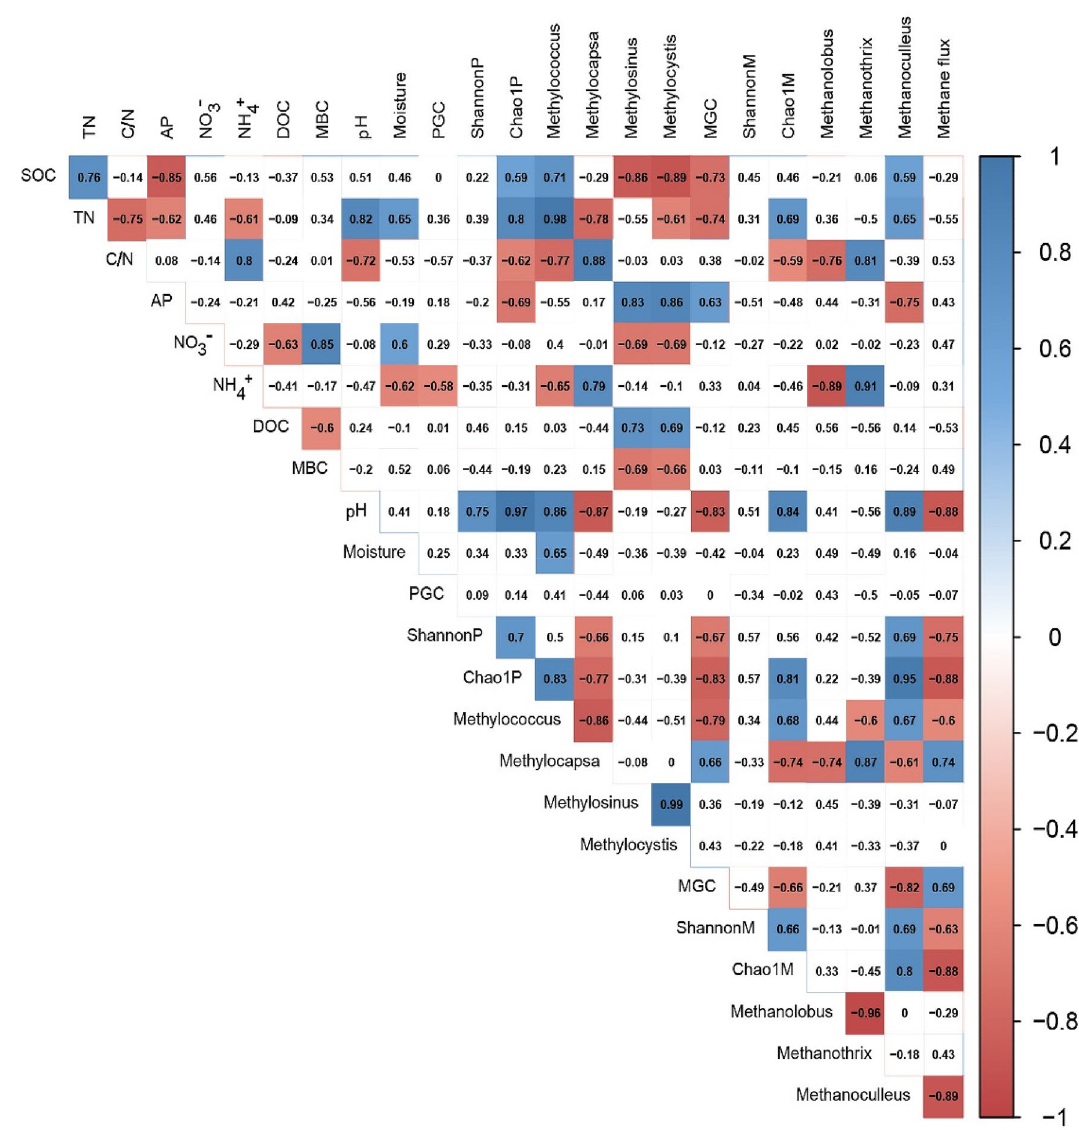
Figure 2. Pearson’s correlation coefficients (R) for relationships between soil properties and methanotroph and methanogen abundance, diversity, and dominant community, and CH 4 flux. SOC, soil organic carbon; MBC, microbial biomass carbon; DOC, dissolved organic carbon; TN, total nitrogen; NO 3- , nitrate; NH 4+ , ammonium; C/N, carbon/nitrogen; AP, available phosphorous; PGC, abundance of pmoA gene; ShannonP, Shannon index for methanotrophs; Chao1P, Chao1 index for methanotrophs; MGC, abundance of mcrA gene; ShannonM, Shannon index for methanogens; Chao1M, Chao1 index for methanogens. The color and numbers shown indicate the strength and sign of the correlation. Lack of color indicates no significant correlations ( P > 0.05). Cool colors indicate significant and positive correlations ( P < 0.05), whereas warm colors indicate significant and negative correlations ( P <